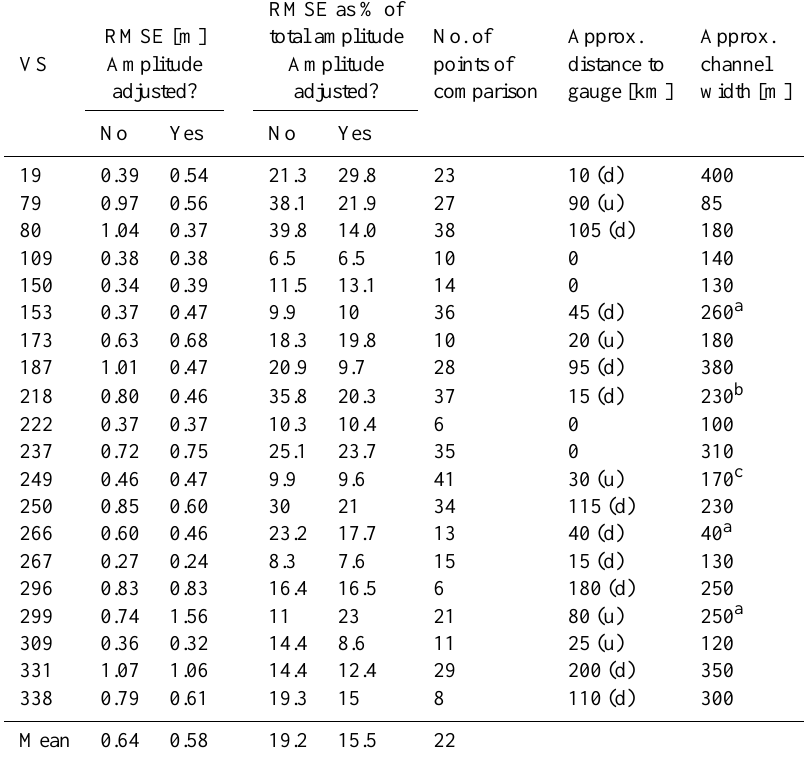
Table 1. RMSE, distance to gauge and high flow channel width. (d) indicates the gauge is located downstream, and (u) upstream from the virtual station. The index “a” after the channel width value indicates the virtual station is located in a channel with a floodplain, the index “b” indicates the presence of pools adjacent to the channel and the index “c” indicates a braided river channel. RMSE as % of RMSE [m] total amplitude No. of Approx. Approx. VS Amplitude Amplitude points of distance to channel adjusted? adjusted?